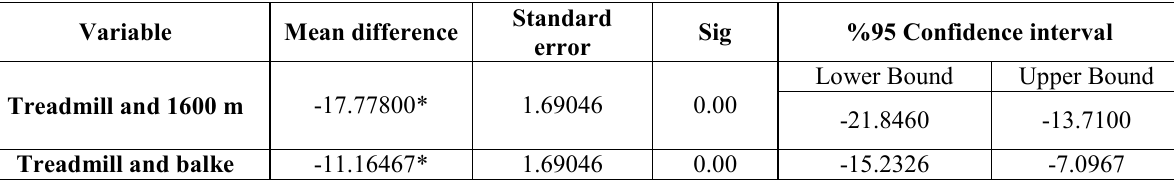
Table 3. Results of Tukey HSD test to compare the treadmill test with average VO2max in the 1600 m and Balke